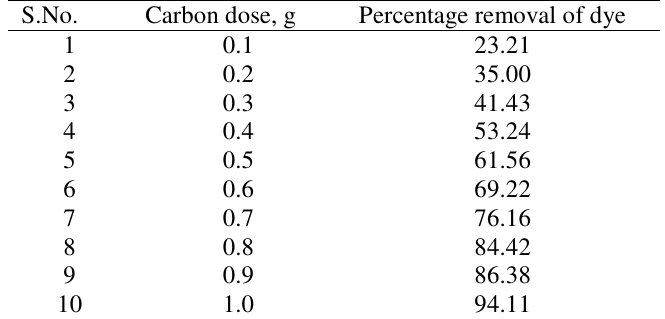
Table 1. Effect of carbon dose ( Concentration of dye: 100 ppm; particle size: 400 µ ; contact time: 5 h; pH 7.0)